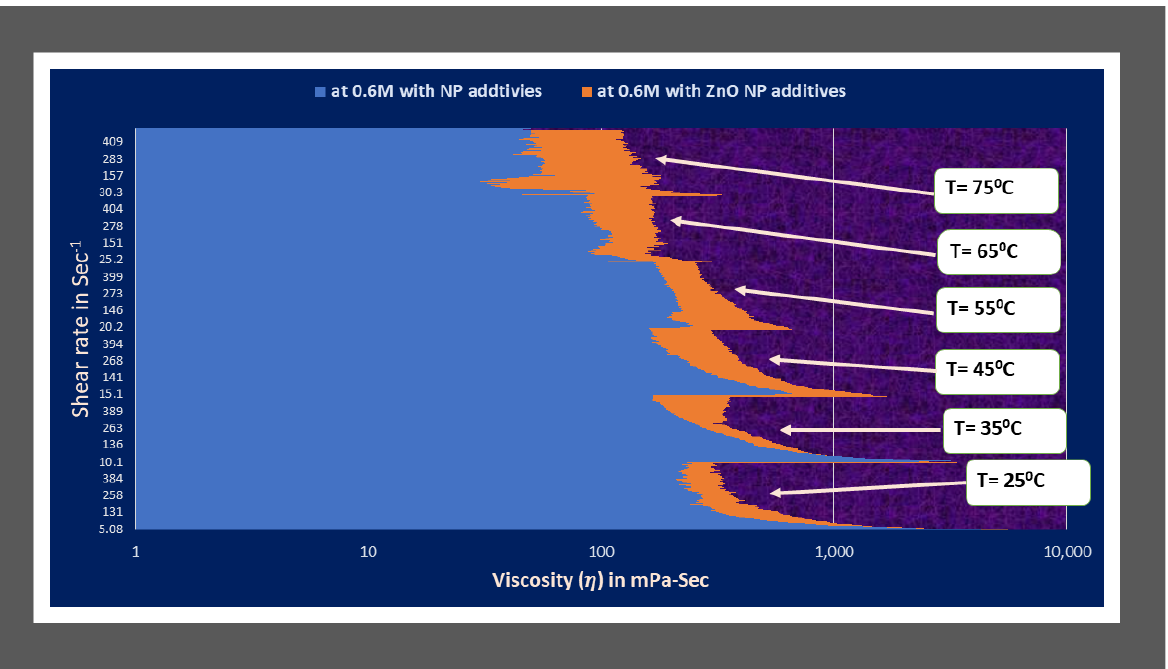
Figure 11. Rheology comparison in terms of viscosity of optimum viscoelastic fluids of type1 (without NP additives) and type2 (with NP additives) fluids at 0.6 M NaNO 3.